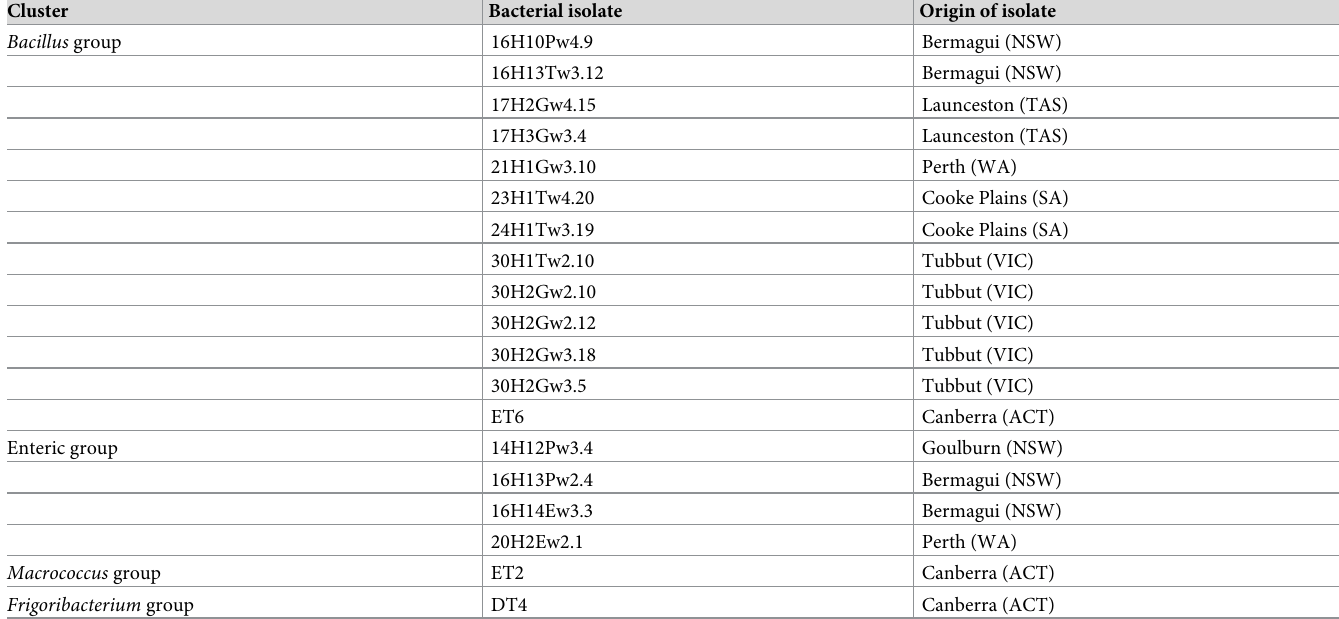
Table 1. Classification, name and origin of aerobic bacteria isolated from the gut of Australian honey (nurse)